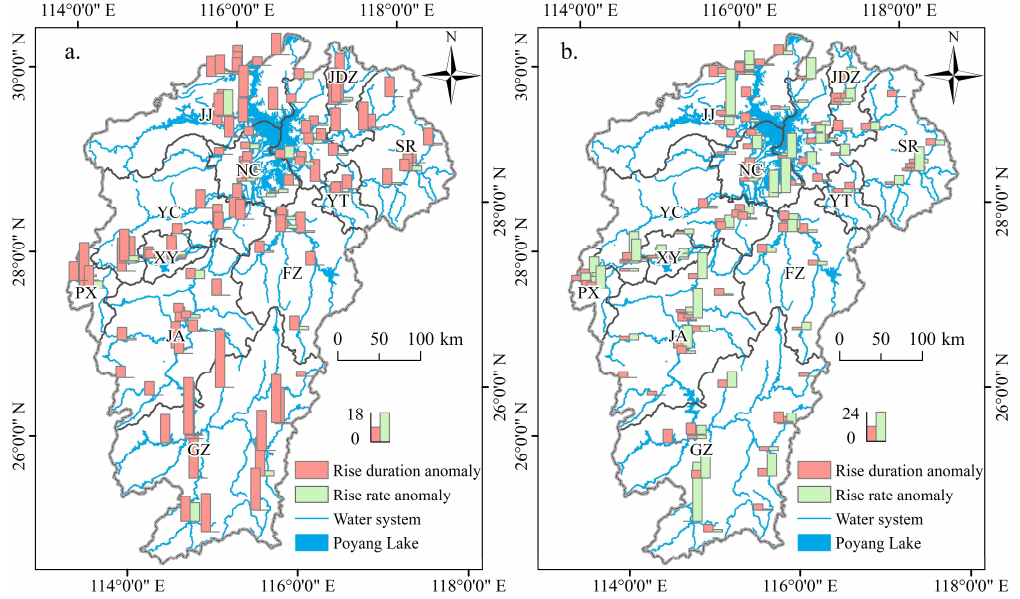
Figure 6. Distribution of the AGLR events by city using the MAD method ( a ) and IQR method ( b